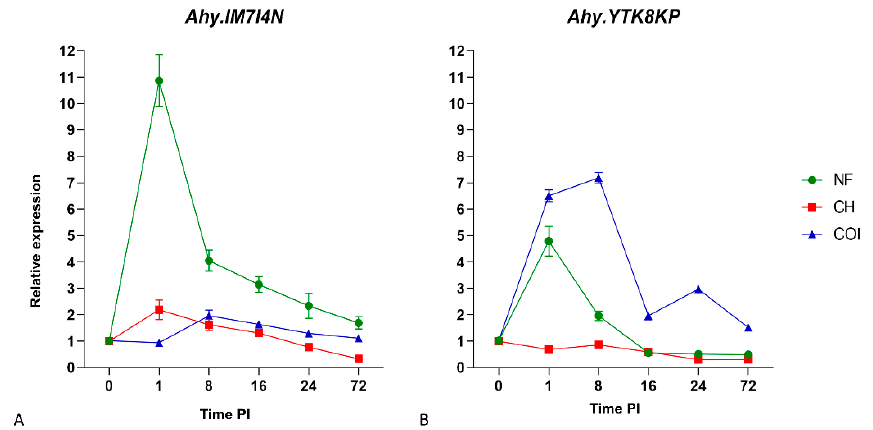
Figure 6. Expression levels of Ahy.IM7I4N ( A ) and Ahy.YTK8KP ( B ) genes in peanut roots. qPCR was performed to evaluate expression levels of both genes after treatment with NF or chitosan. Actin expression levels were used to normalize the data. All data is the mean of 3 biological replicates ± S.E. Different letters indicate significant differences among the treatments for each time point analyzed according to Fischer LSD p ≤ 0.05. Figure was drawn using GraphPad.